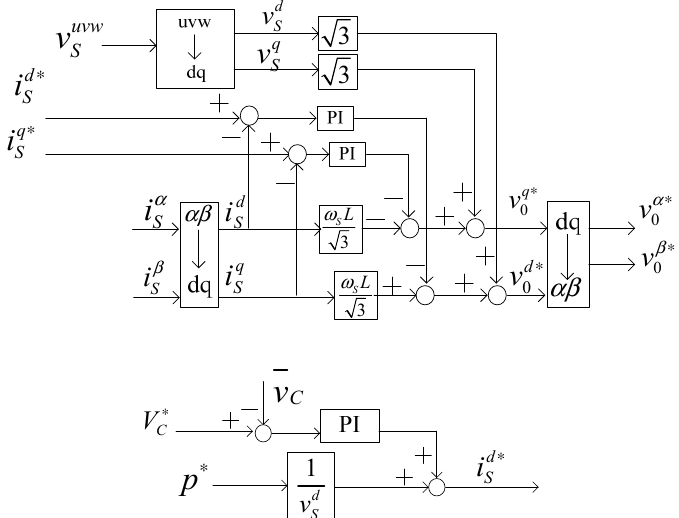
Figure 9. Control block diagram of the primary side system.